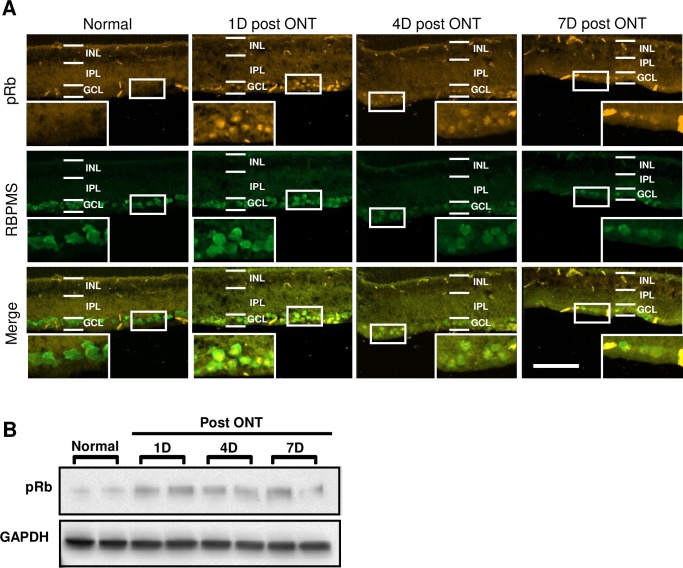
ONT induces pRb expression.(A) Immunofluorescent micrographs of transverse sections of the retina showing nuclear pRb expression in RGCs after ONT, at 1, 4, or 7 days postaxotomy. Scale bar = 100 μm. (B) Western blot of whole retinal lysates demonstrating elevated levels of pRb in transected retinas. Each band represents a whole retina.